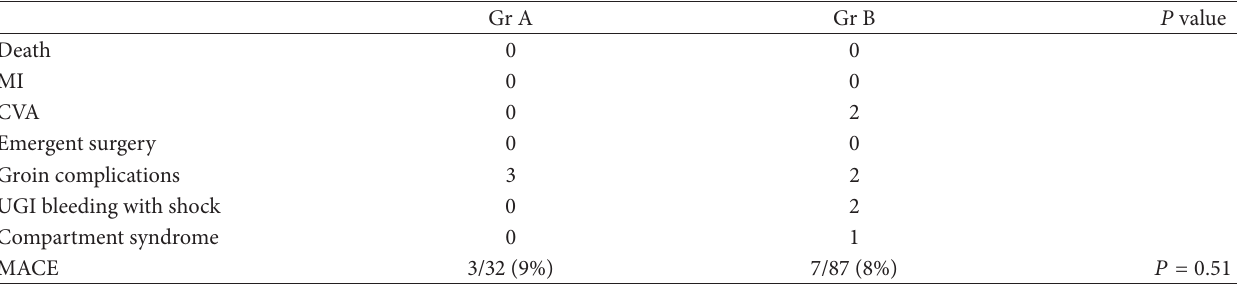
Table 4: In-hospital and 30-day outcomes.